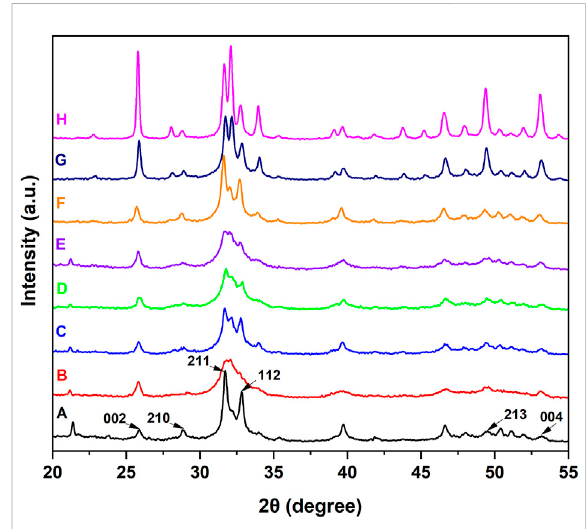
FIGURE 5 XRD patterns of dentin disks after treatment with NovaMin (C) , ACP (D) , or IgY@ACP (E) for 1 day and treatment with NovaMin (F) , ACP (G) , or IgY@ACP (H) for 7 days. Normal (A) and demineralized dentin disks (B) were used as the control group.